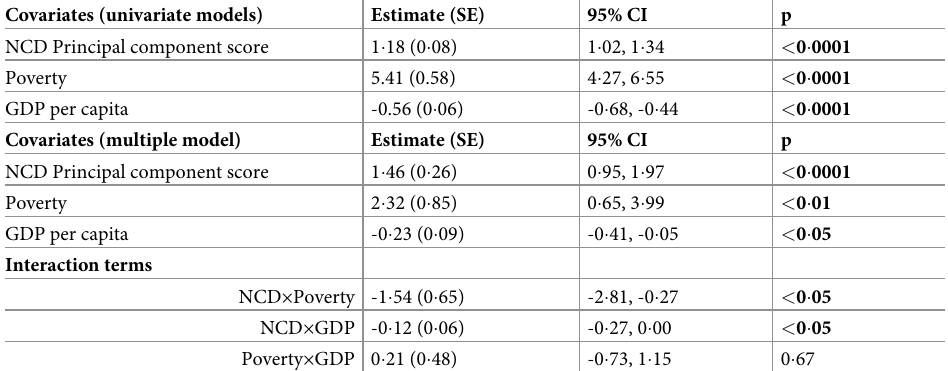
Table 1. Multiple linear regression model for OPD adjusted with a logit link